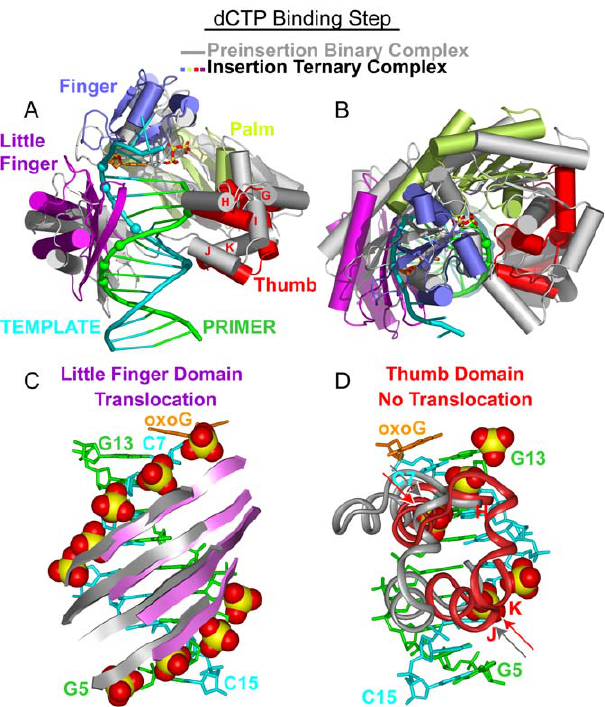
Figure 4. Conformational Transitions of Dpo4 and oxoG-Modified Template-Primer DNA Associated with the Nucleotide-Binding Step Following Superimposition of DNA